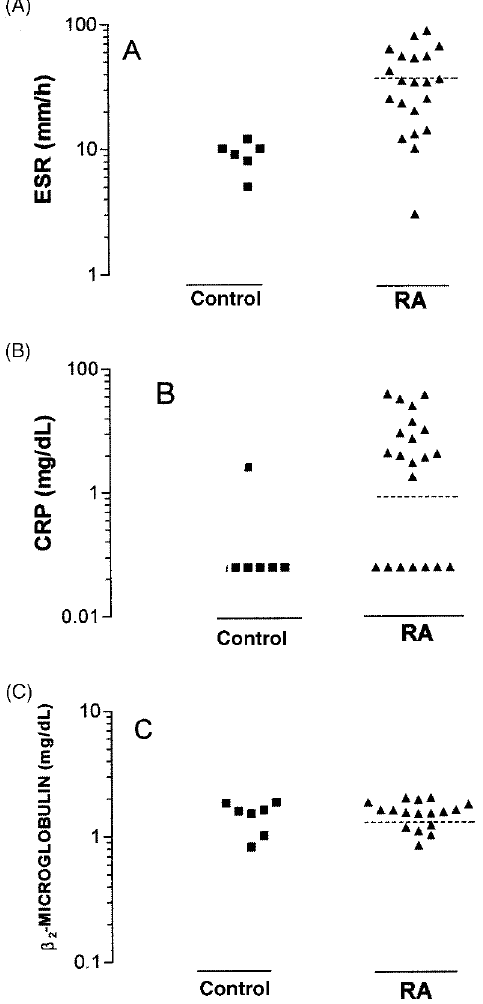
FIG. 1. Individual values of ESR (A), CRP (B) and b 2 -micro- globulin (C) in both control and RA groups. The dotted line indicates the median.